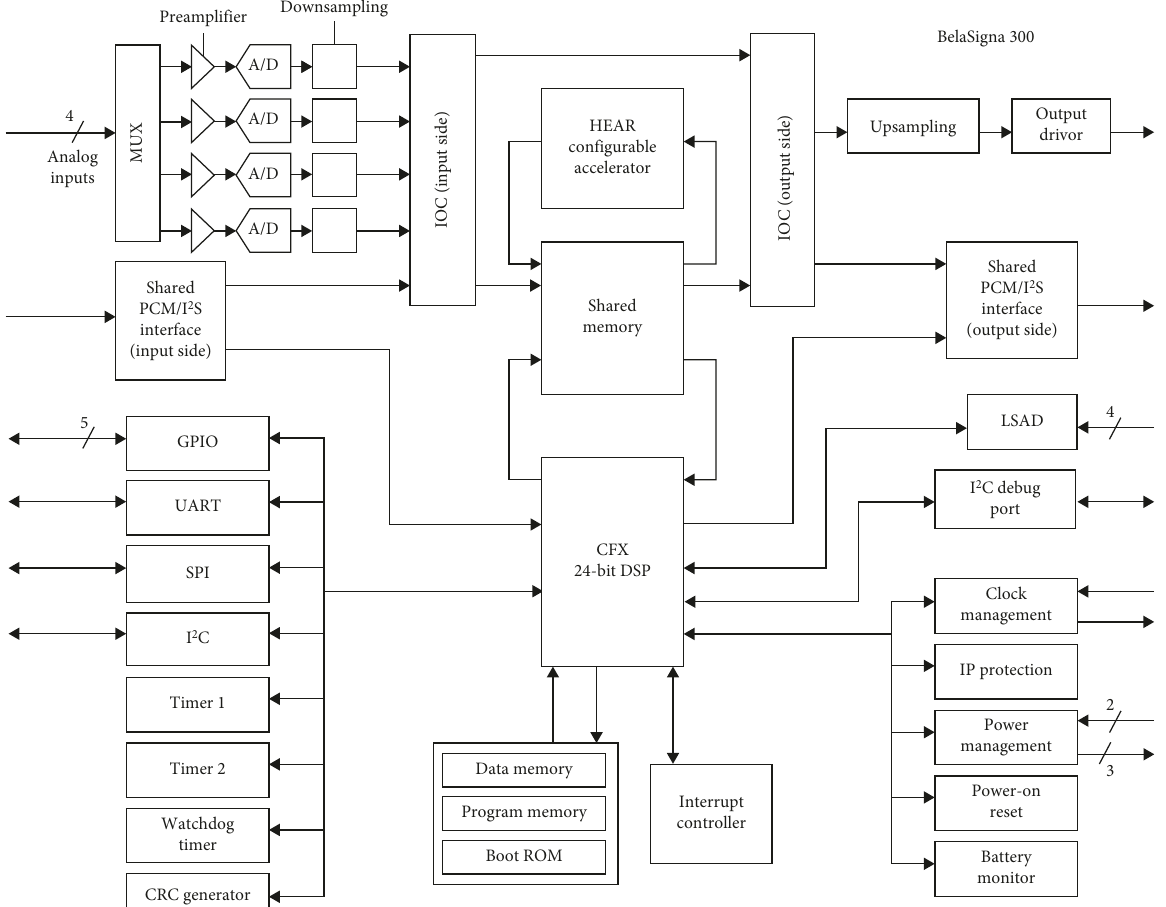
Figure 8: Belasigna 300 system